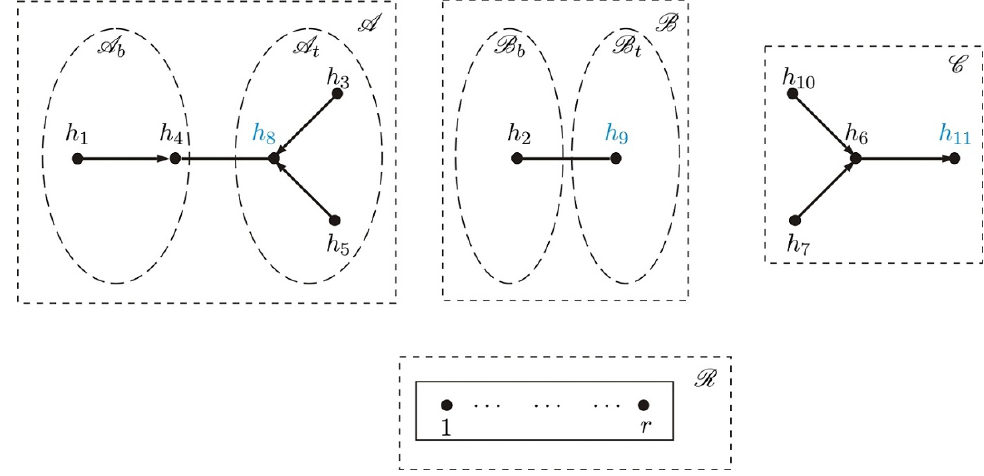
Figure 11 . A skeleton consisting of four mutually disjoint components for the gauge invariance induced identity eq. (2.9) with j H j = 11. The reference order is chosen as R = f h 1 ; h 2 ; : : : ; h 10 ; h 11 g . Here, both A and B are type-I components. The kernel of A is given by the nodes h 4 and h 8 with a type-1 line between them (i.e. the factor (cid:15) h (cid:1) (cid:15) h ), while the kernel of B is given by h 2 4 8 and h 9 with a type-1 line between them (i.e. (cid:15) h (cid:1) (cid:15) h ). On each side of the component A , the 2 9 arrows of type-2 lines point to the corresponding end node of the kernel. The component C is the type-II component. The set R = f 1 ; : : : ; r g itself is the type-III component (Although only the elements 1, . . . , r (cid:0) 1 can play as roots in the graphic rule, we also include the last element r in the component R for convenience; a more general type-III componnet can involve type-II lines whose arrows pointing to